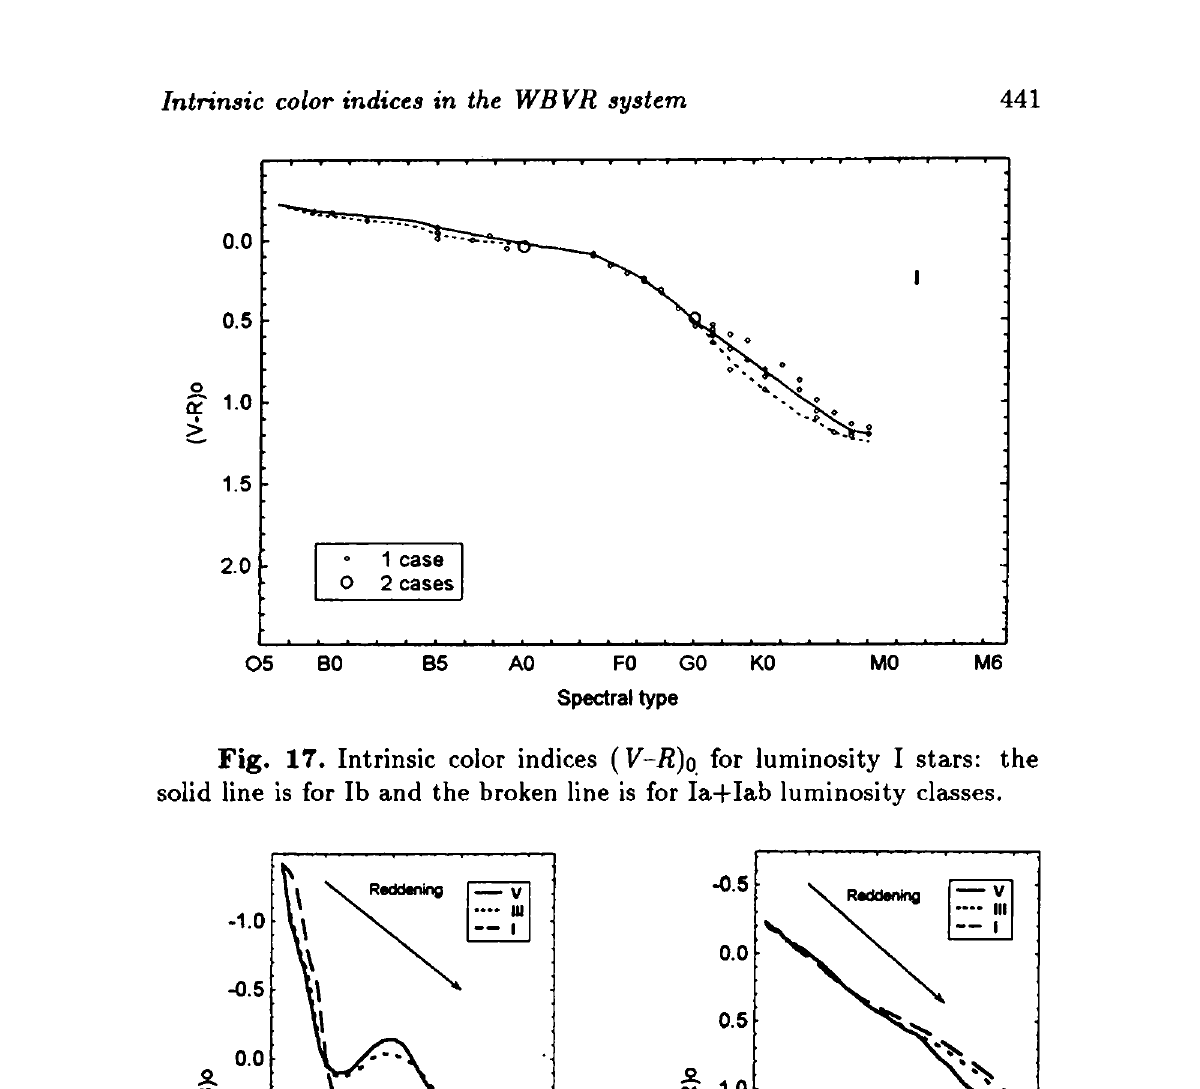
Fig. 18. Intrinsic sequences of Fig. 19. Intrinsic sequences of luminosity V, III and I stars in the luminosity V, III and I stars in the W-B, Β- V diagram. V-R, Β- V